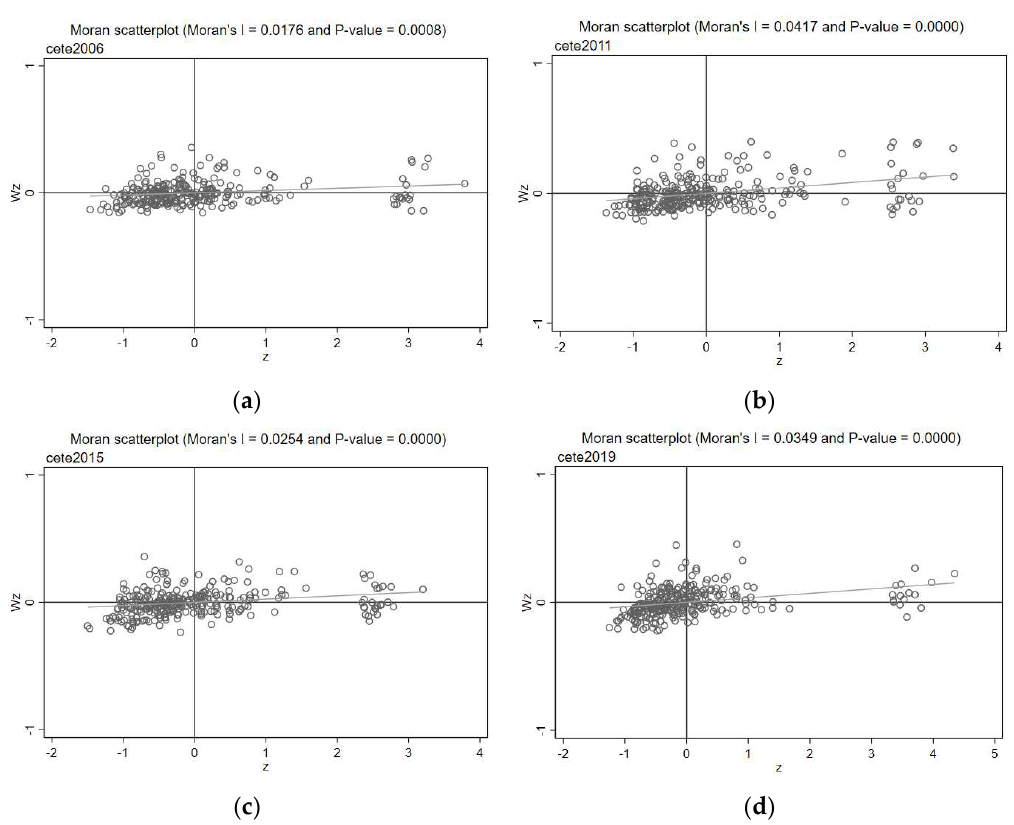
Figure 1. Moran Index and scatter plot of green development performance of Chinese cities in 2006 ( a ), 2011 ( b ), 2015 ( c ), and 2019 ( d